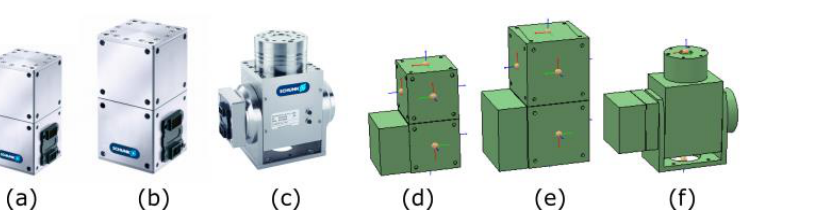
Figure 2. Schunk joint modules: ( a ) PR 70; ( b ) PR 90; ( c ) PW 70. The simulated counterparts: ( d ) PR 70; ( e ) PR 90; ( f ) PW 70. Table 1. Joint module physical parameters. Table 2. Joint module parameters used for optimization.